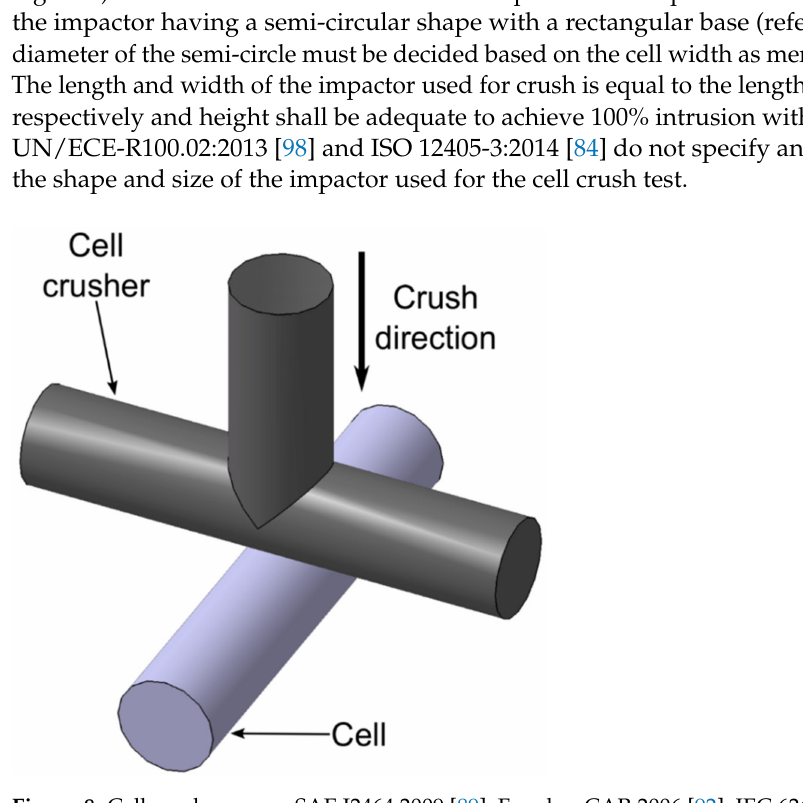
Figure 8. Cell crusher as per SAE J2464:2009 [89], FreedomCAR:2006 [92], IEC 62660-2:2010 [87], and SAND2017-6925:2017 [107].